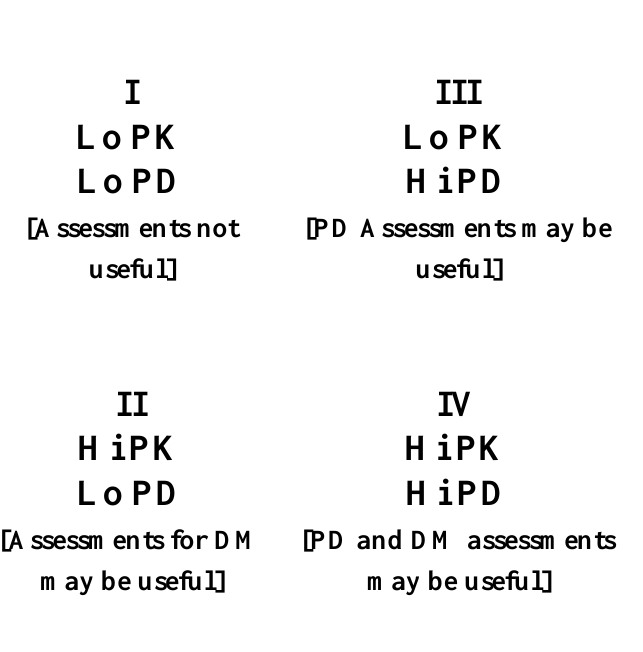
Figure 2. Pharmacokinetic/Pharmacodynamic variability and the utility of assessing a patient to individualise therapy. Therapies falling into quadrant I are unlikely to benefit from phenotypic or genotypic testing; Quadrants II and IV may benefit from a pharmacokinetic assessment (genetic or non-genetic) of drug metabolising enzymes or transporters; Quadrants III and IV may benefit from a pharmacodynamic assessment (genetic or non-genetic) to identify likelihood of clinical response. Controlling variability is more useful for drugs with a narrow therapeutic index. DM = Drug Metabolism/transporters; PK = Pharmacokinetics; PD =